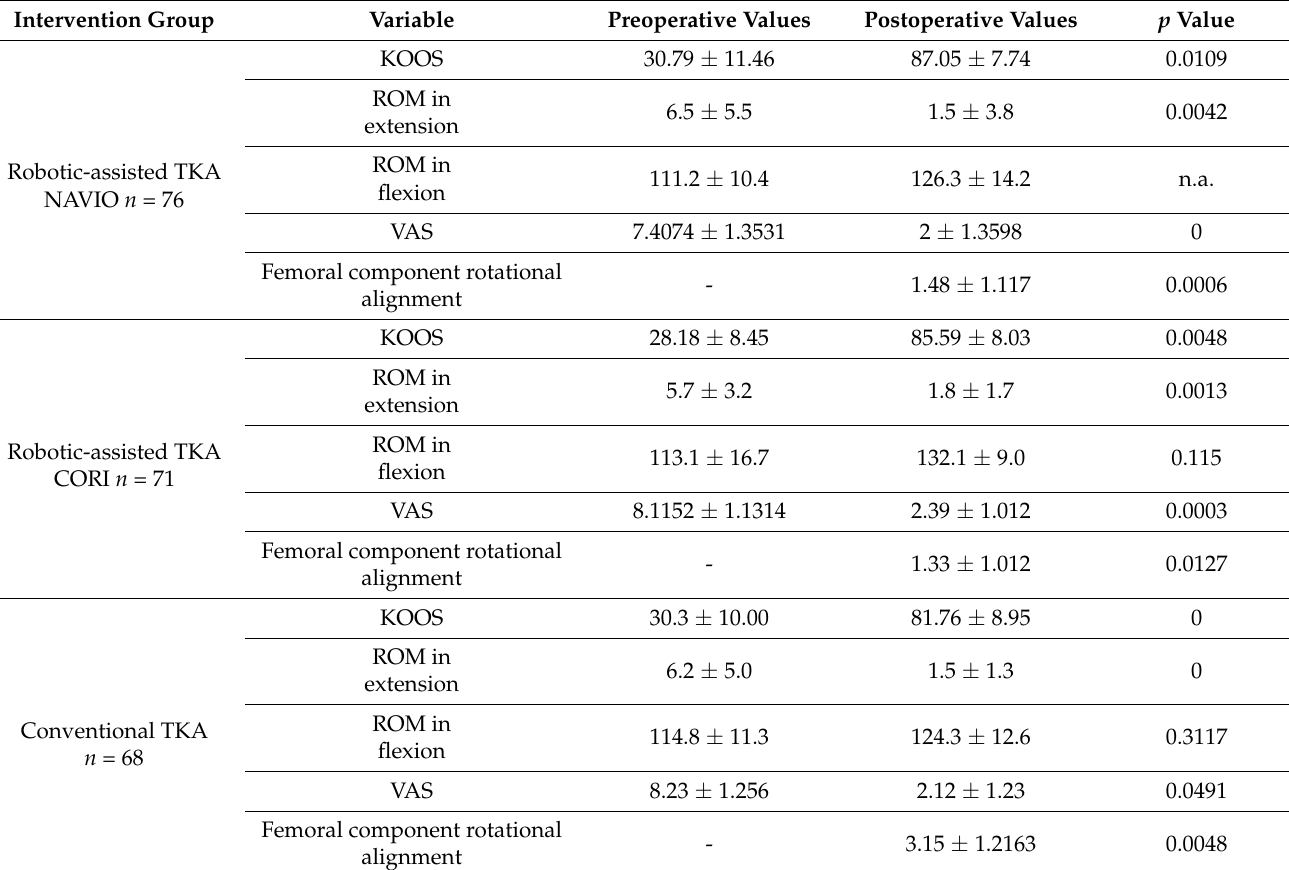
Table 4. Results of clinical and radiographic outcomes for dependent values in intervention